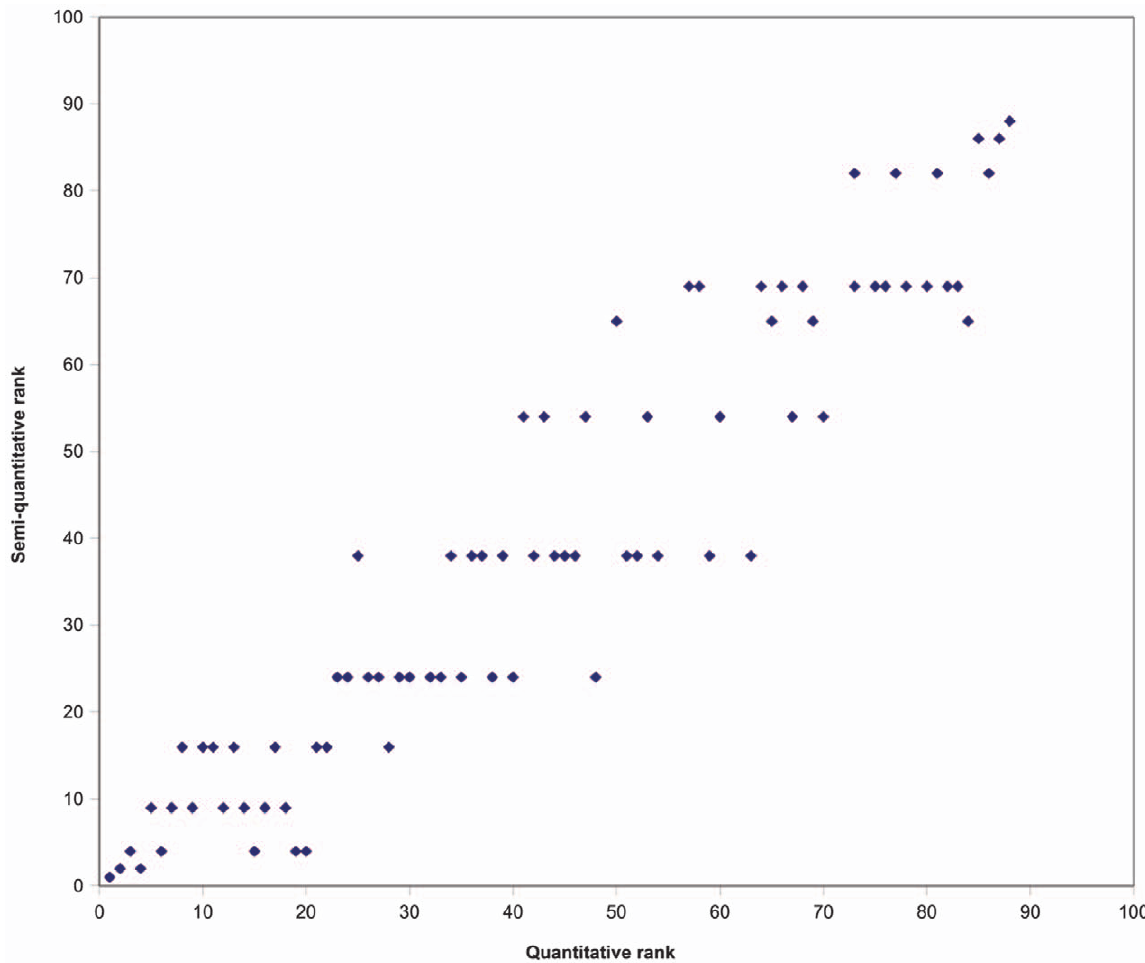
Figure 5. Comparison of ranking using quantitative and semi-quantitative model.